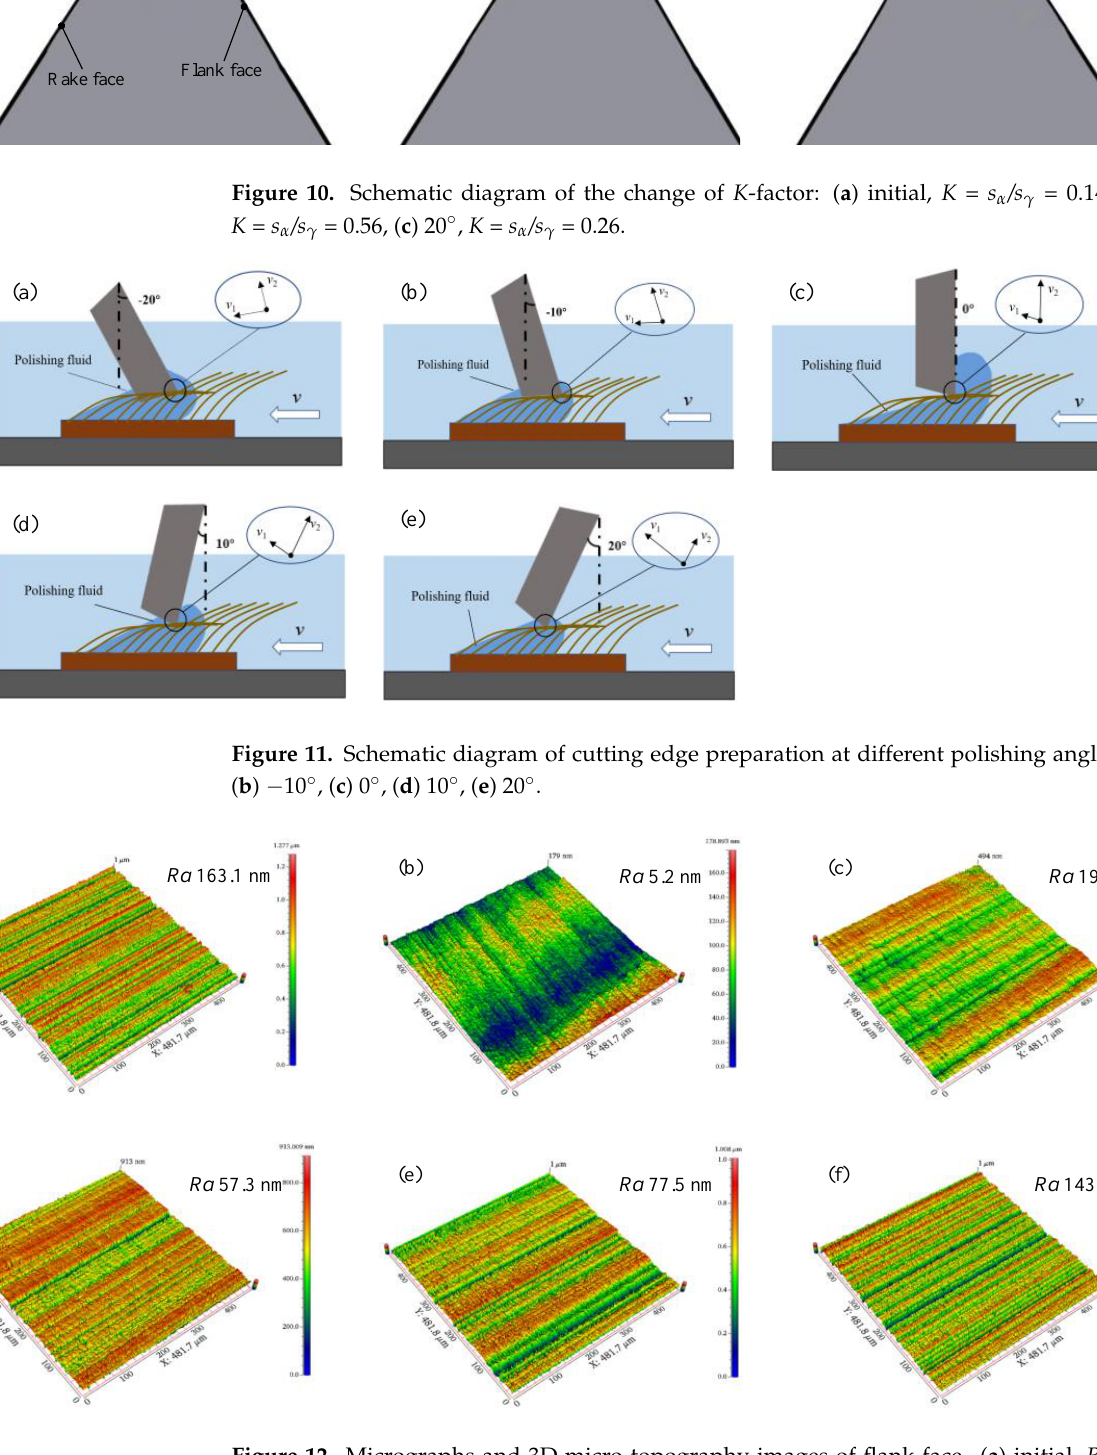
Figure 11. Schematic diagram of cutting edge preparation at different polishing angles: ( a ) – 20°, ( b ) − 10°, ( c ) 0°, ( d ) 10°, ( e ) 20°.